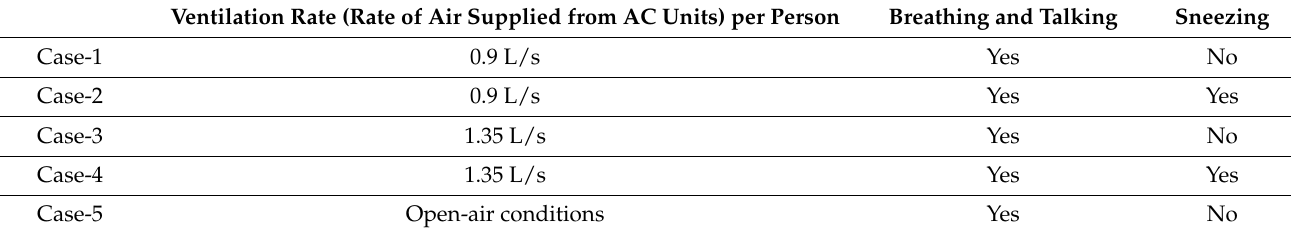
Table 1. The list of cases investigated in the present